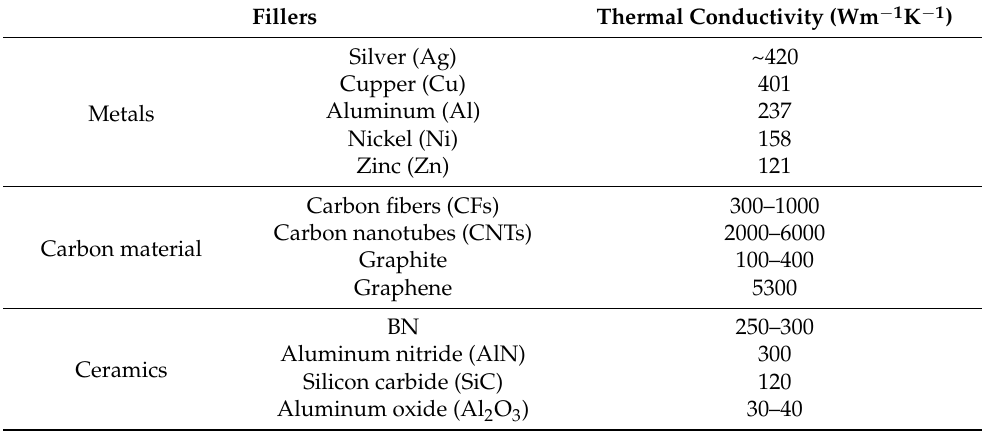
Table 1. Thermal conductivities of commonly used thermally conductive fillers